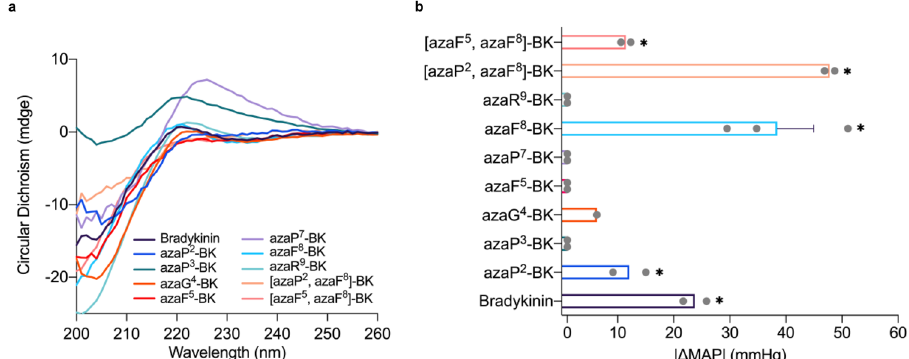
Fig. 4 | Structural activities and hypotensive effects of bradykinin and BK- based azapeptide analogues. a Circular Dichroism (CD) spectra of bradykinin- based azapeptides. Bradykinin azapeptide analogues were scanned from 200 to 260nmonCDspectrometerfor3repeatsperpeptide.TheCDspectrawereplotted by using the average value of three repeats. b Hemodynamic effects (hypotensive) of intravenous bolus injections (6.4 µ g/kg) of bradykinin and bradykinin azapep- tides indicated by absolute change in mean arterial pressure (MAP) in rats. Each